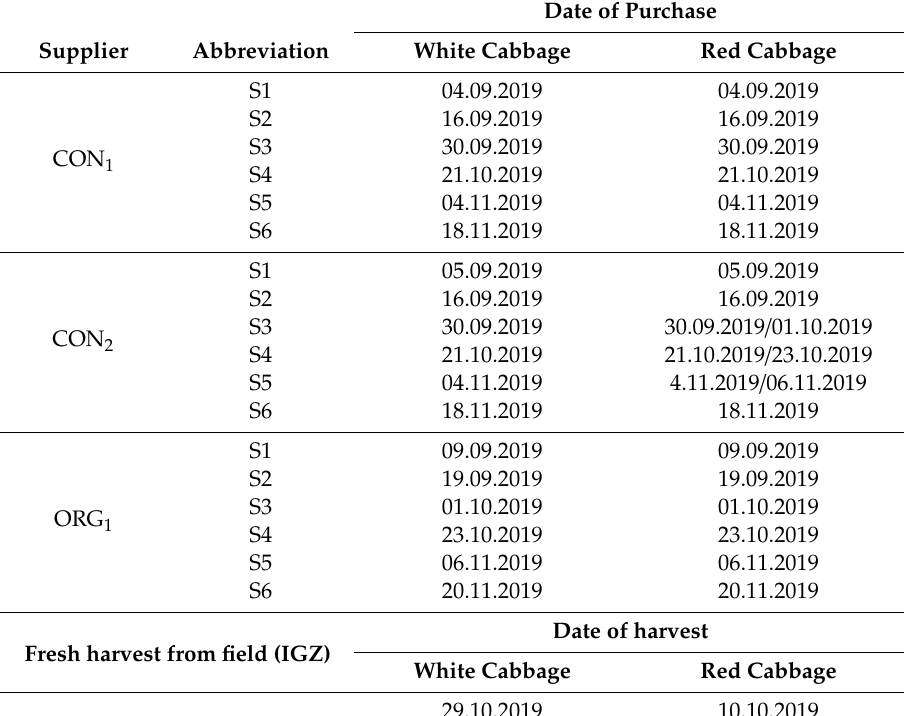
Table 1. Overview of the dates of the purchased and harvested red and white cabbage